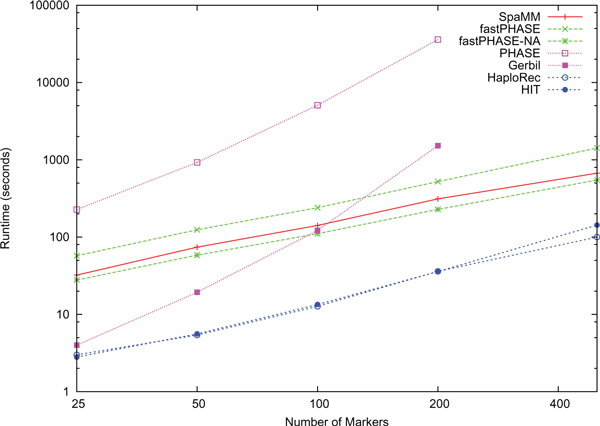
Runtime as a function of the number of markers. Average runtime per dataset on Yoruba datasets for marker maps of length 25 to 500 for SpaMM, fastPHASE, fastPHASE-NA, PHASE, Gerbil, HaploRec, and HIT are shown (logarithmic scale). Results are averaged over 10 out of the 100 datasets in the Yoruba collection.